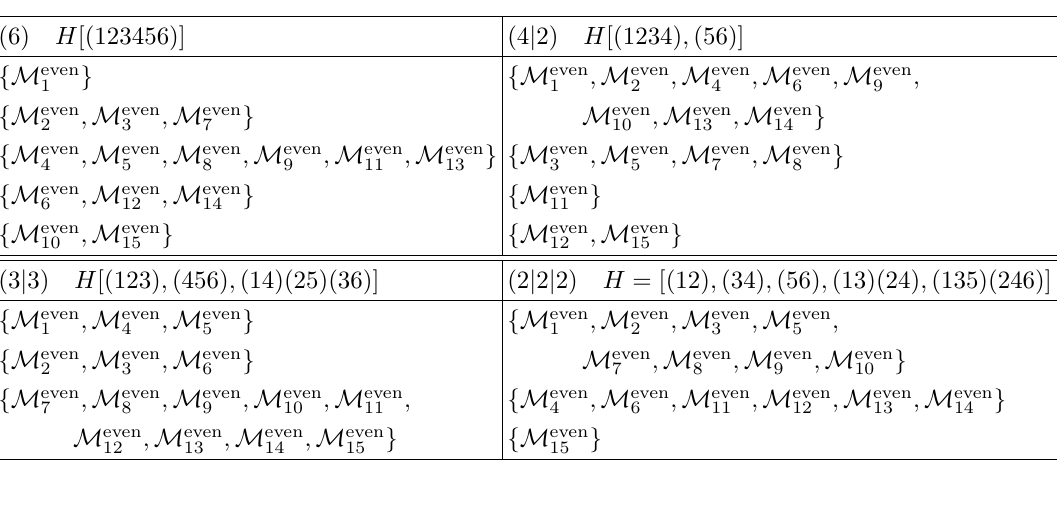
Table 5 . Orbit spaces for 6-point O ( p 6 ) soft blocks, organized for each class of 6-point trace structures. The generators of the invariant subgroups H are also provided in the square